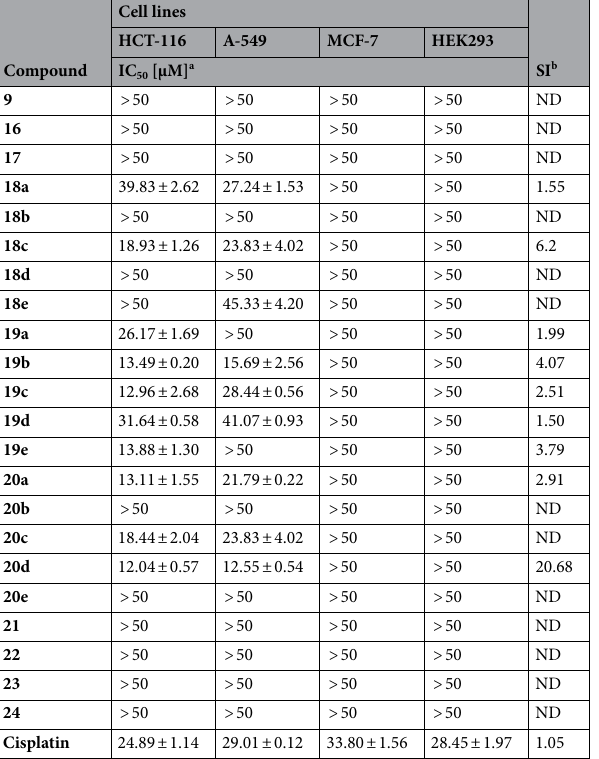
Table 1. In vitro anticancer activity of investigated compounds (IC 50 ± SD (µM)) towards human colon cancer (HCT-116), non-small cell lung adenocarcinoma (A-549), and human breast carcinoma (MCF-7), human and embryonic kidney cells (HEK293). a IC 50 value represent a concentration that inhibits 50% of cell growth. b SI value represent selectivity indexes (IC 50 HEK-293 /Average IC 50 cancer cell lines ); ND: not determined, since the compound was inactive in the experimental